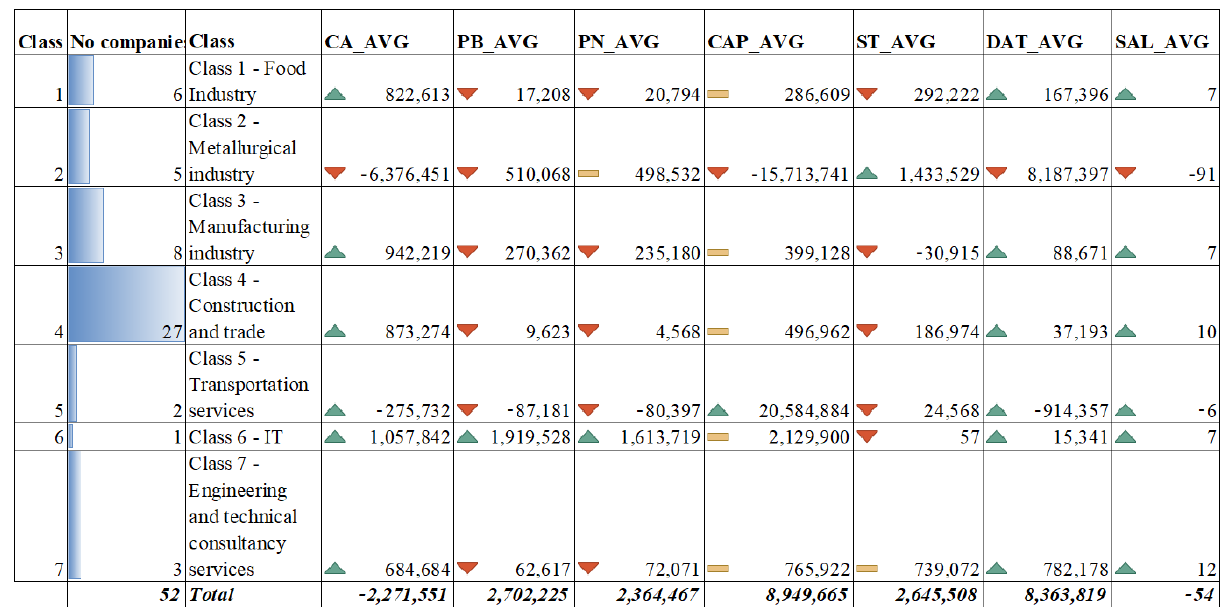
Figure 6. Evolution of performance indicators highlighted by the main categories of financial and patrimonial interest for the studied entities. Source: Authors’ processing based on the information provided on Topfirme.com. Accessed date: 5